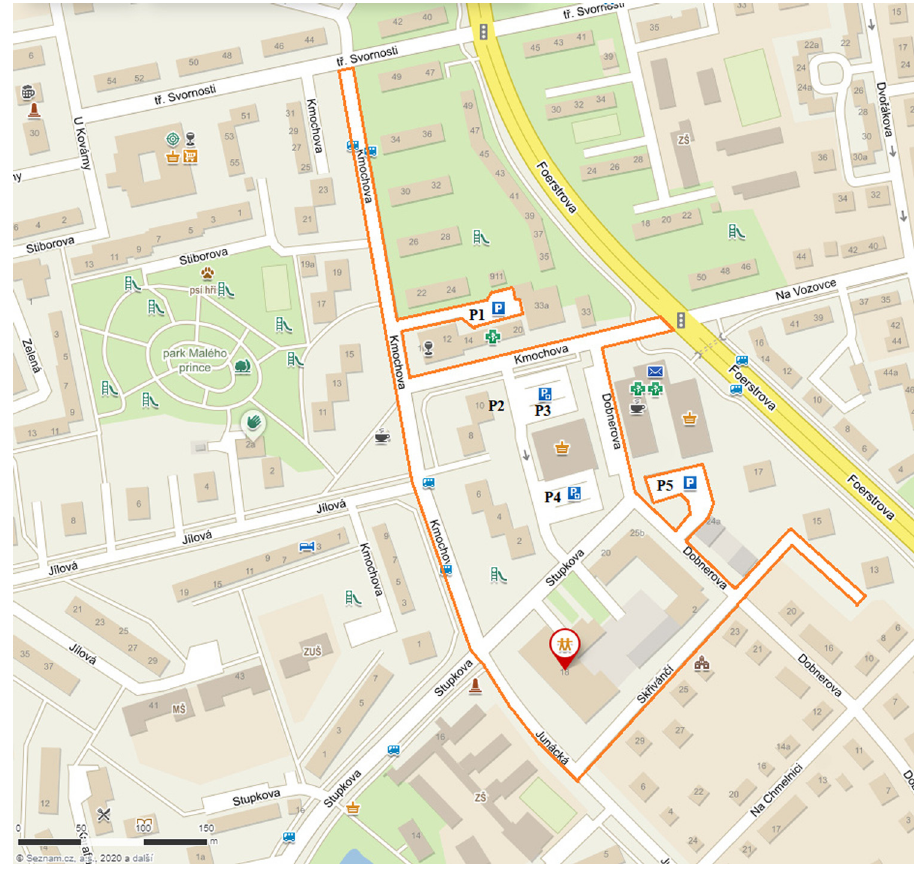
Figure 2: Map of the monitored Foerstrova area [ 16 ] .